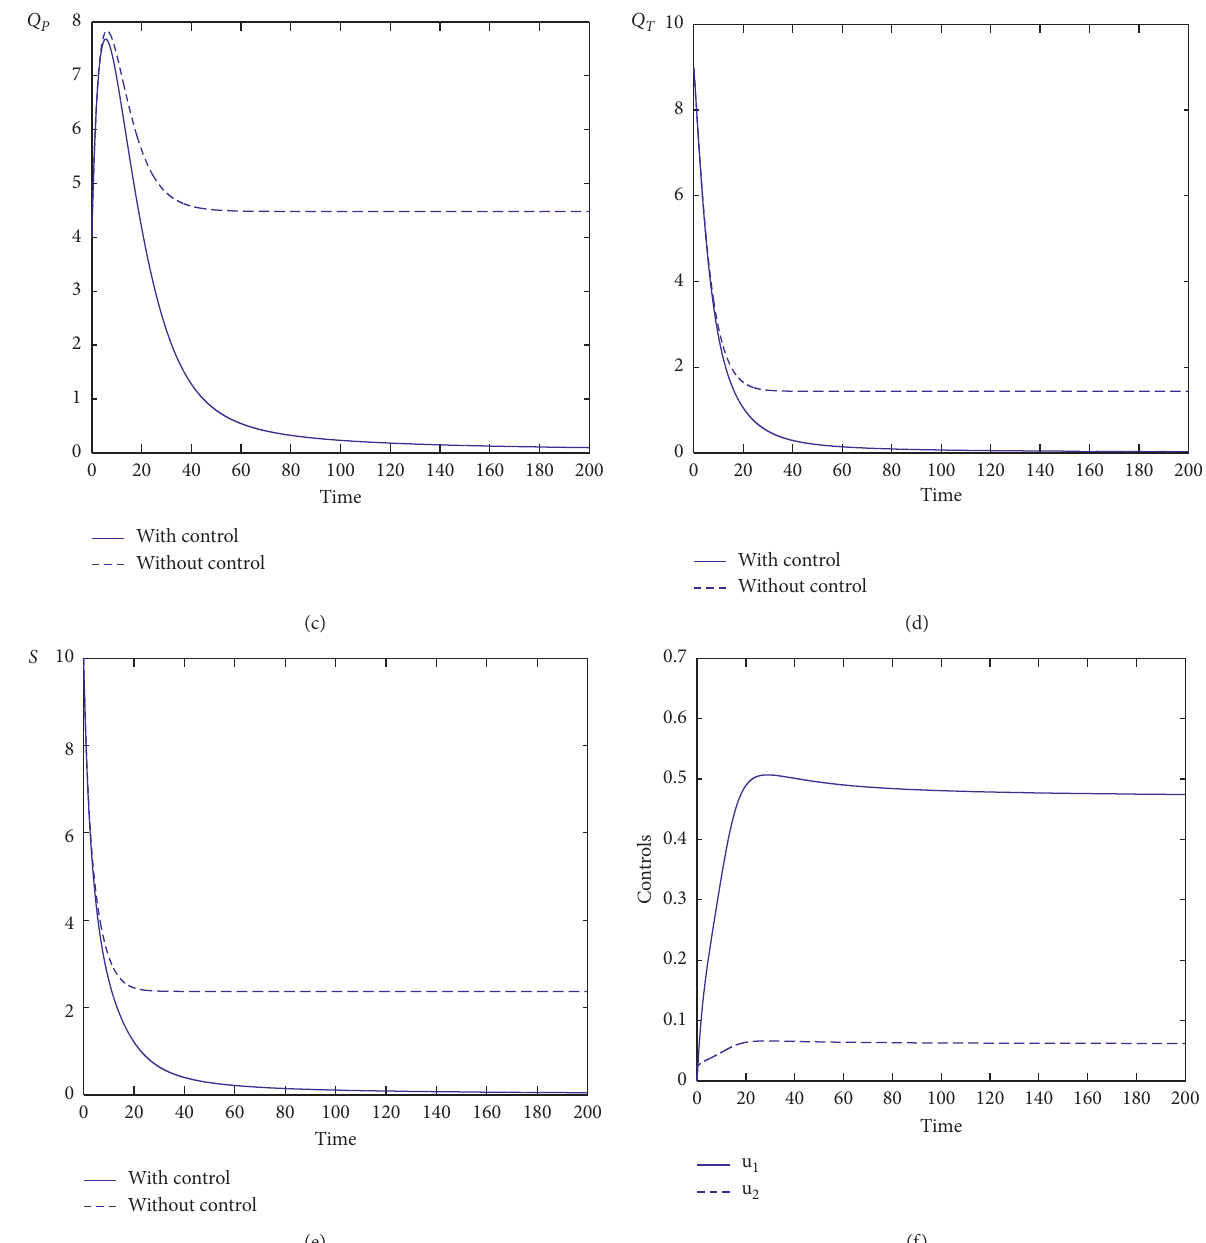
Figure 4: The effect of the control on the evolution of the